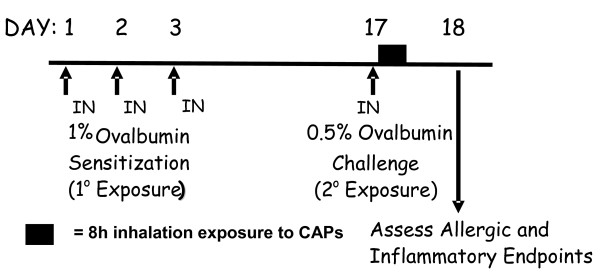
Experimental protocol of CAPs exposure during allergen challenge. Brown Norway rats were sensitized with intranasal (IN) ovalbumin (OVA) for 3 consecutive days, and then challenged with IN OVA or vehicle 14 days later. Within 30 min rats were exposed to filtered air or CAPs for 8 h, and allergic airway responses were assessed one day later.